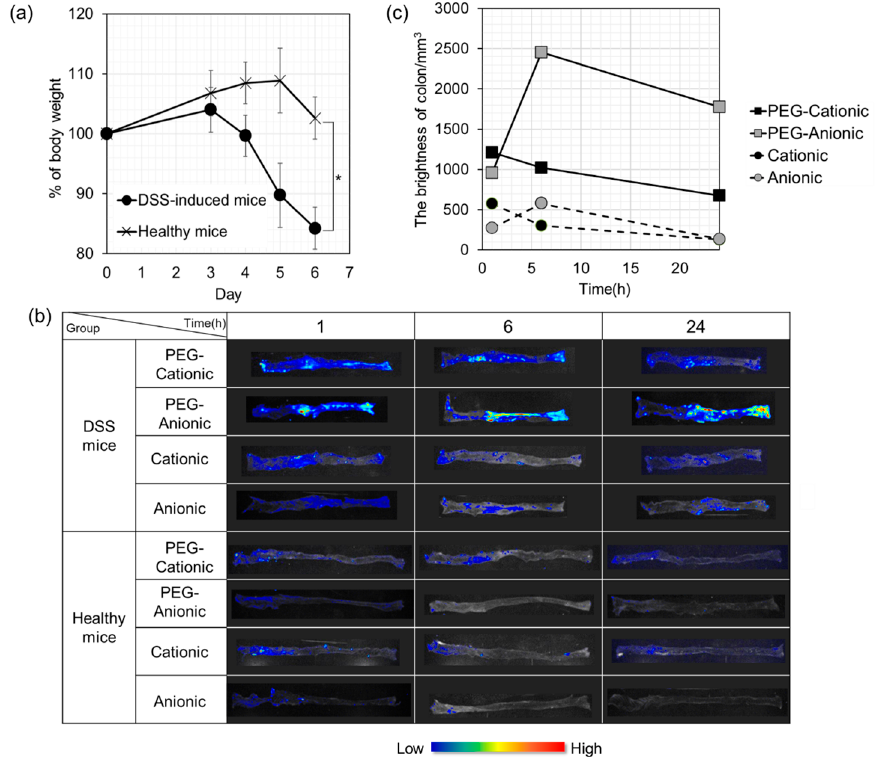
Figure 3. Accumulation of various liposomes in dextran sulfate sodium salt (DSS)-induced mice. ( a ) Weight loss in mice orally administered DSS. Each bar represents mean ± S.D (DSS-induced mice, n = 24; healthy mice, n = 15). ( b ) In vivo imaging of colon in response to intravenous liposome administration. ( c ) Brightness of various liposomes in DSS-induced mouse large intestines determined by Maestro TM v. 2.4.